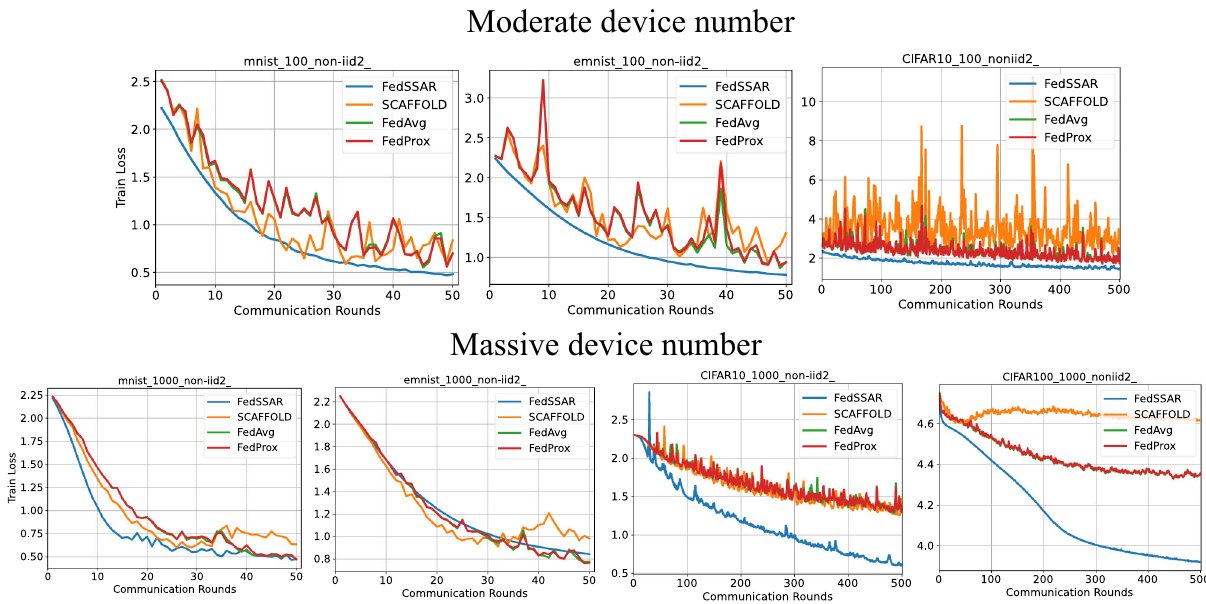
Fig. 13 Training loss of FedSSAR and other methods, using decreasing η t and weight decay to achieve the best training performance during the last 50 training rounds for MNIST and EMNIST-L, 500 for Cifar-10 and Cifar-100 (non-IID2